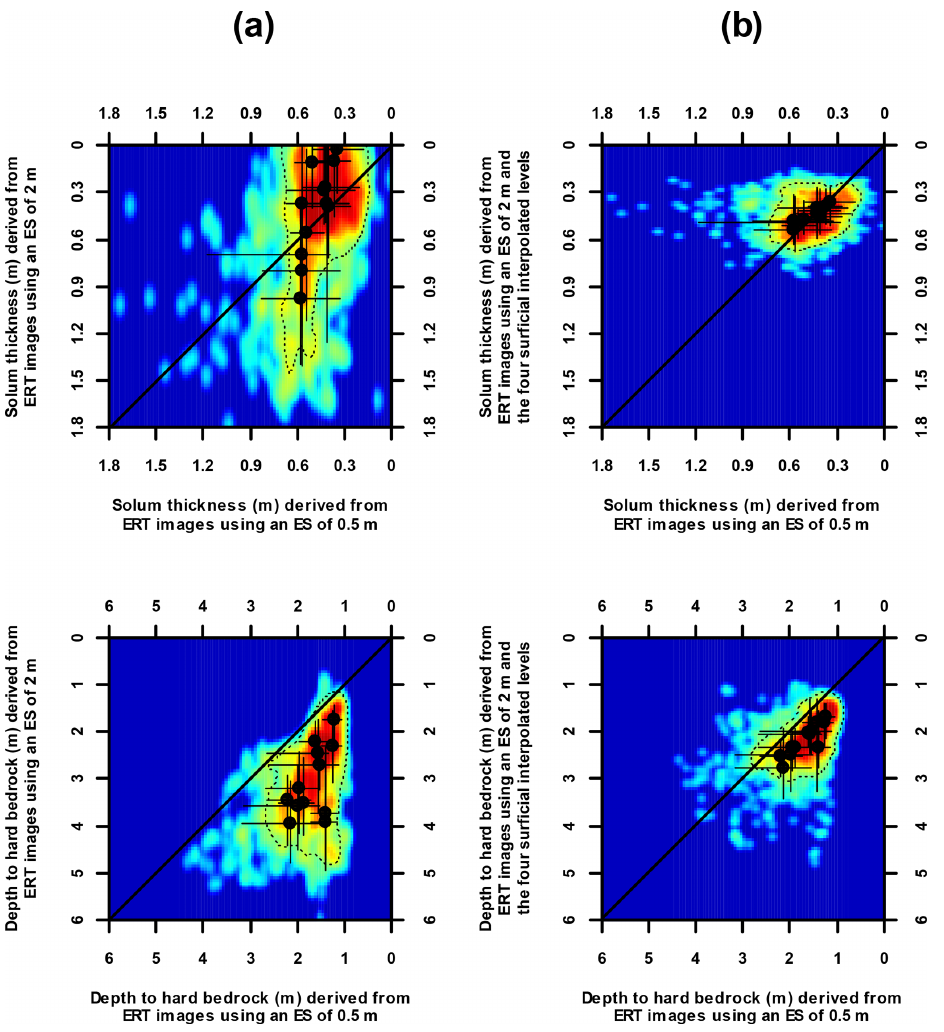
Figure 12. Coloured density scatter plots (red – high density – to blue – low density) showing solum thickness and depth to hard bedrock derived from the 12 plot-scale ERT profiles measured in the Weierbach catchment using an ES of 0.5m vs. those using an ES of 2m without (a) or with the four interpolated levels of surficial apparent resistivity (b) . Median values and interpercentile ranges of 10%–90% of the interface depth of each ERT profile are shown by black dots and thin vertical and horizontal bars. Envelopes defined by thin dashed black contours encompass 80% of individual pairs of